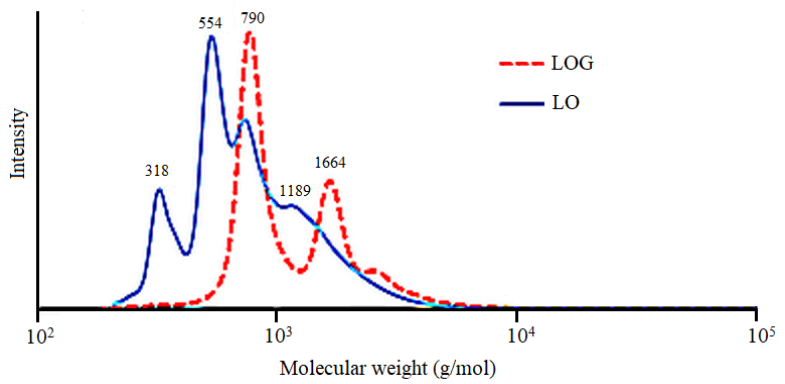
Figure 2. Gel permeation chromatography (GPC) diagrams of LO and LOG.